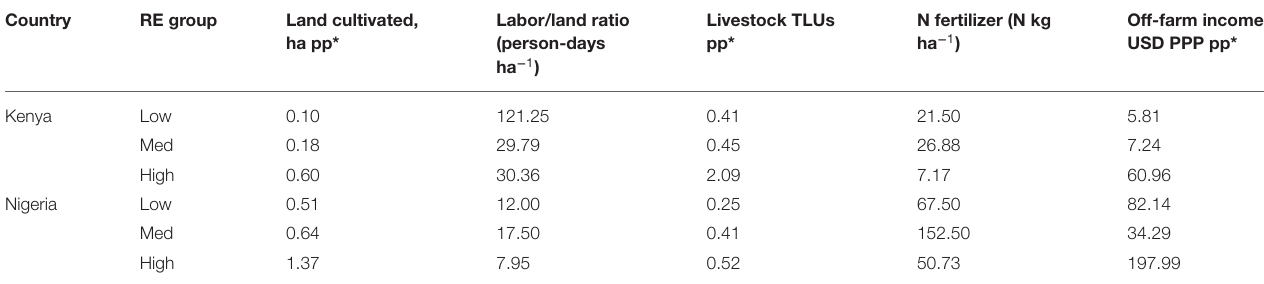
TABLE 1 | Median resources available to farms in each RE group. Country